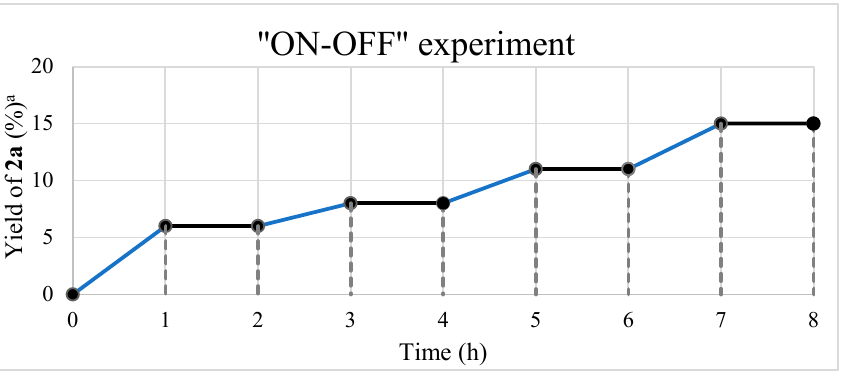
Figure 3. Result of the ON-OFF experiment using 1a and styrene. Reaction conditions: 1a (28.6 mg, 0.2 mmol) and styrene (0.09 mL, 0.8 mmol) in DCM/H 2 O (2.0 mL, 4/1) under 365 nm UV irradiation and O 2 atmosphere.